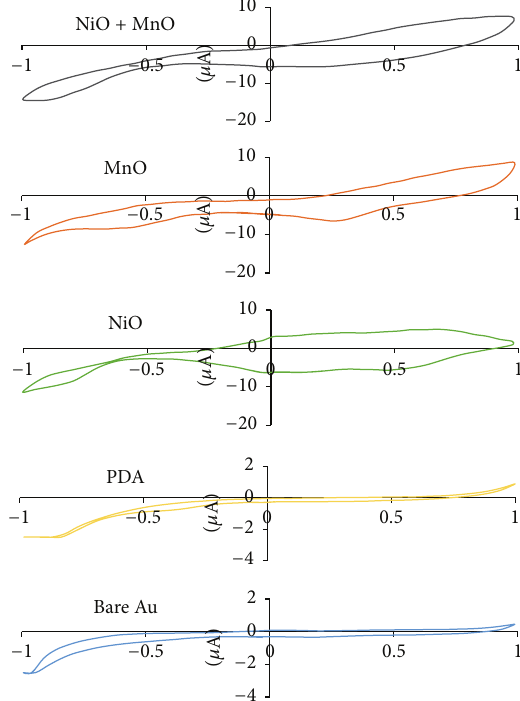
Figure6:Cyclicvoltammetryofmodifiedgoldelectrodesfrom − 1 V to +1V at scan rate 50 mVs −1 . All curves correspond to 3rd